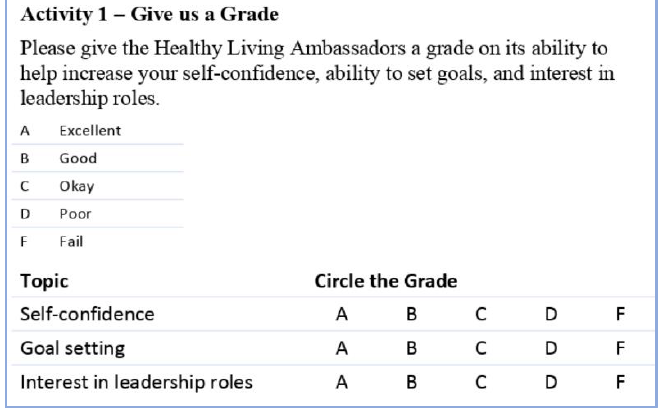
Figure 1. Give Us a Grade — Activity 1 Example